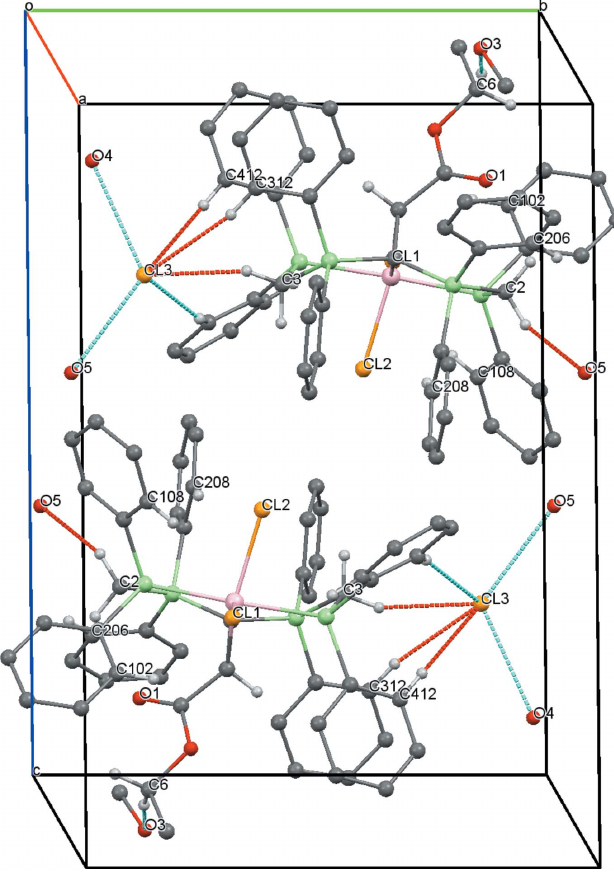
Figure 7 Aview along the a axis of the crystal packing of compound 5 . Only the H atoms involved in the most significant intermolecular interactions (Table 3) are presented and the intramolecular interactions are omitted. One phenyl group and the solvent molecules show positional disorder.